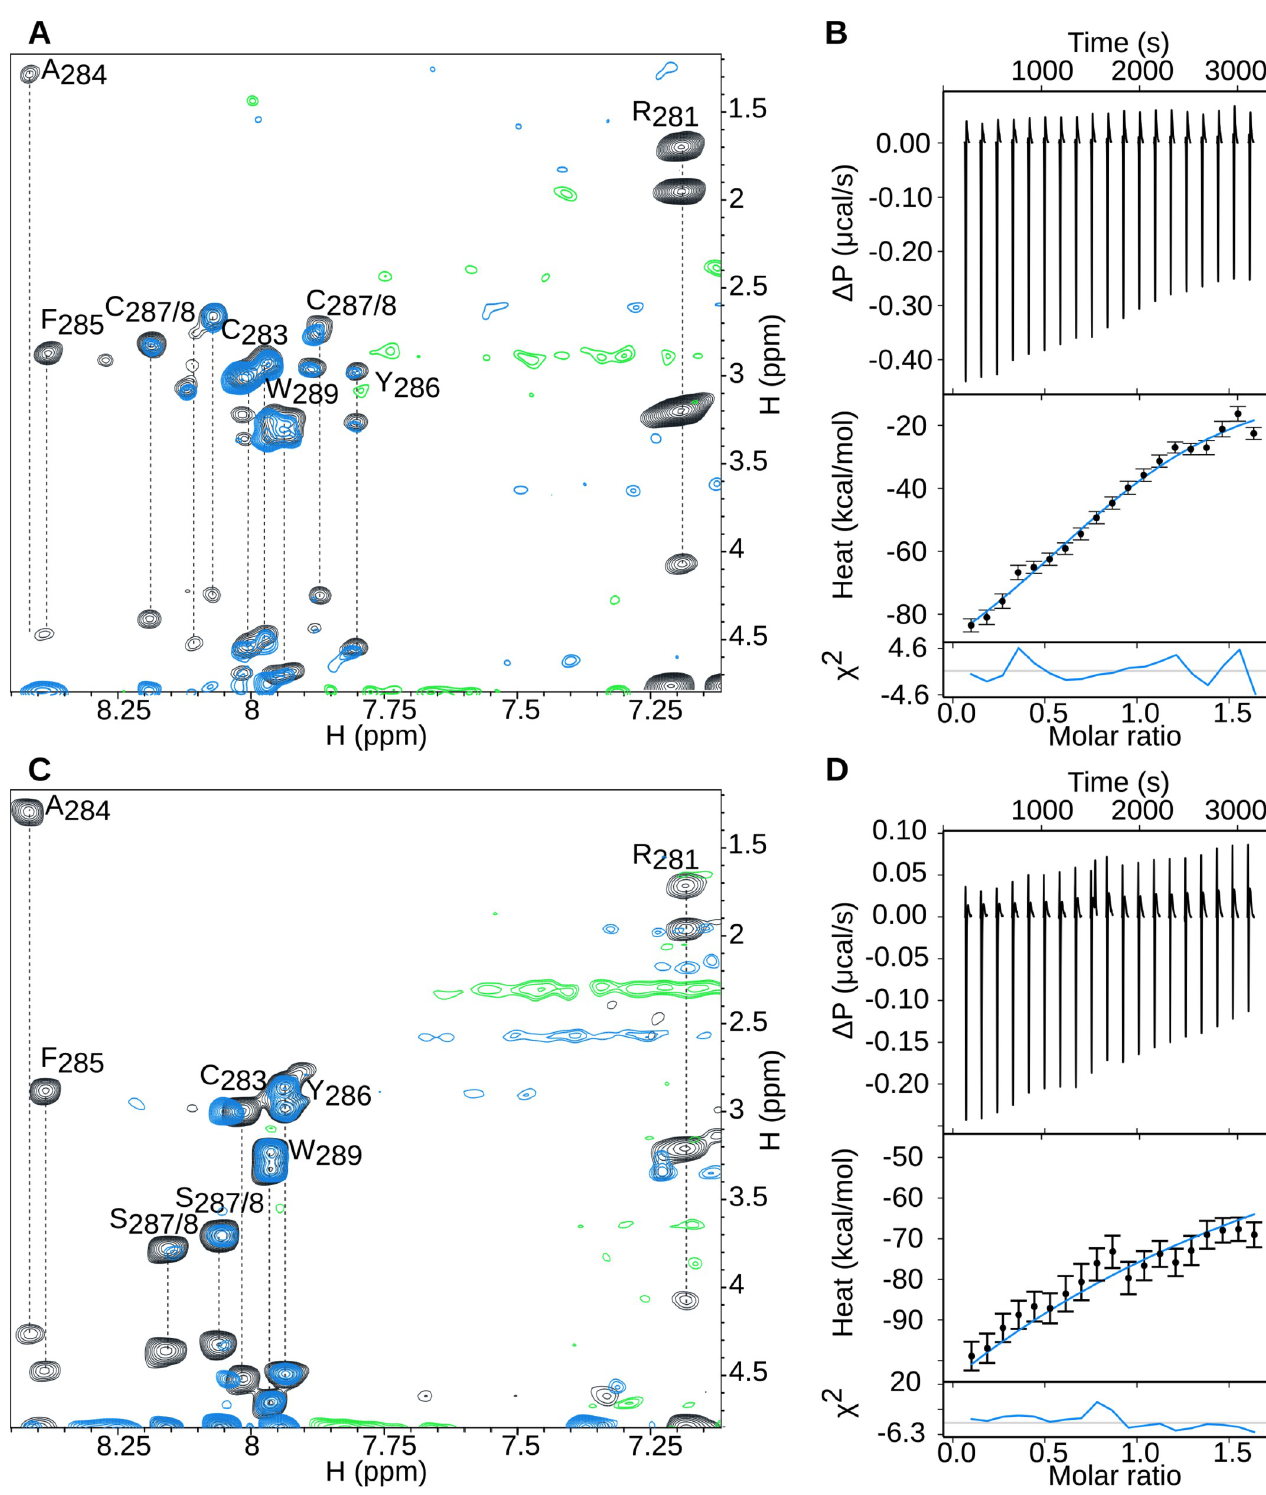
Fig 2. E1B 55K-RNP peptides interact with TPL RNA 196nts in vitro . ( A) Expanded region of an overlay of TOCSY spectra of free WT peptide (black) and WT peptide bound to the TPL RNA 196nts probe (blue). ( B) Heat exchanged from each injection of WT peptide into a solution containing the TPL RNA 196nts probe. (C) Expanded region of an overlay of TOCSY spectra of free C287S/C288S peptide (black) and C287S/C288S peptide bound to the TPL RNA 196nts (blue). (D) Heat exchanged from each injection of C287S/C288S peptide into a solution containing the TPL RNA 196nts. The thermograms were best fit to a one binding site